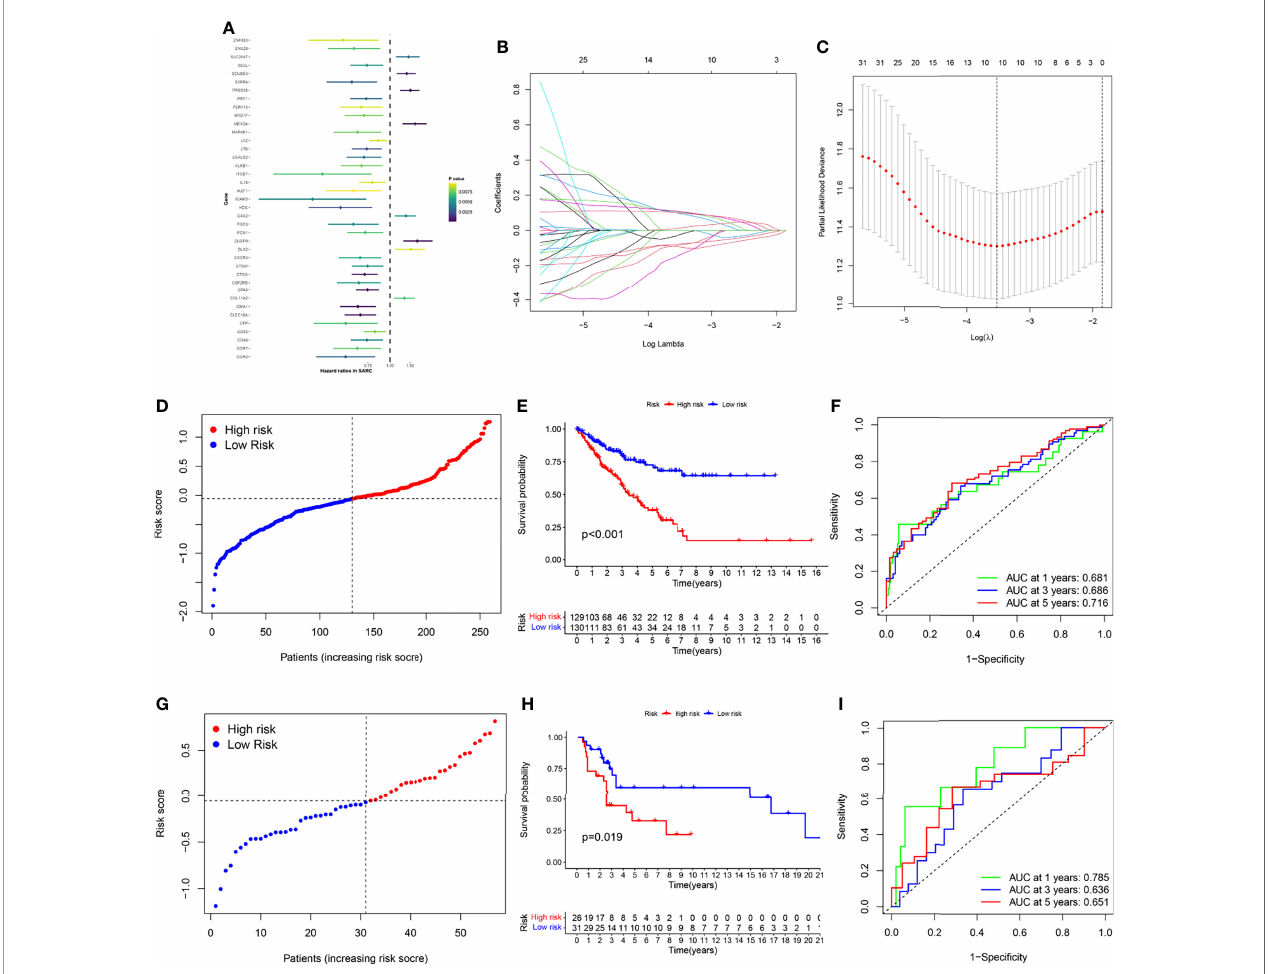
FIGURE 6 | Gene signature ’ s development and validation. (A) 39 DEGs with signi fi cant prognostic differences using univariate Cox regression analysis. (B) LASSO regression analysis of 39 DEGs (C) Cross-validation method to select optimal genes. (D) TCGA-SARC cohort was distributed by risk score. (E) OS curve of TCGA- SARC cohort. (F) Evaluate the prognostic performance of the risk score using time-dependent ROC in TCGA-cohort. (G) GSE17118 cohort was distributed by the risk score. (H) Disease-free survival (DFS) curve of GSE17118 cohort. (I) Evaluate the prognostic performance of the risk score using time-dependent ROC in the GSE17118